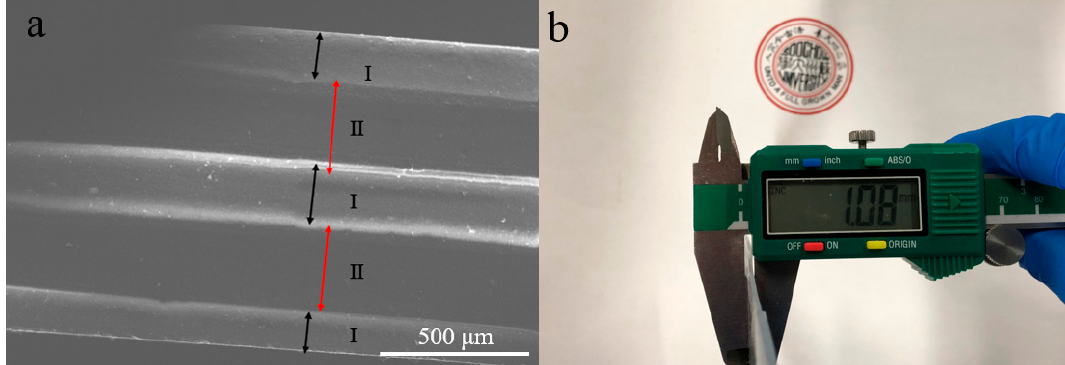
Figure 2. ( a ) SEM image of the flexible sensor at cross-section. The insulating layers are marked as I and the flexible conductive PDMS/CB layers marked as II. ( b ) Thickness of the assembled flexible sensor device. From top to bottom the individual layers were 175, 275, 200, 275 and 150 µm thick. Total thickness was 1.075 mm. Table 1. Summary of performance of flexible capacitive strain and pressure sensors reported in the literature. Sensors were evaluated over four aspects: Fabrication process, capacitive gauge factor (G) for strain sensors, characterization as a wearable sensor and characterization of sensor durability. This sensor’s G factor was within the median of the reported range, though < 1. Of the strain sensors characterized as wearable devices only Shintake et al. [53] and this sensor were evaluated for durability (10 k cycles).